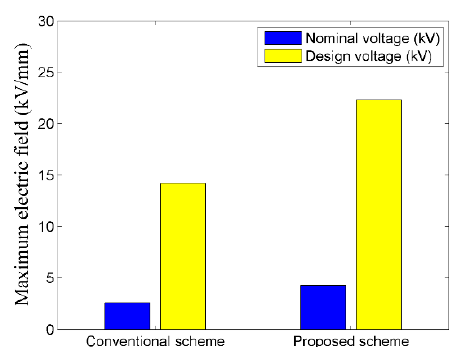
Figure 22. Field intensity comparison of conventional and proposed GIL schemes regarding nominal and design voltages.